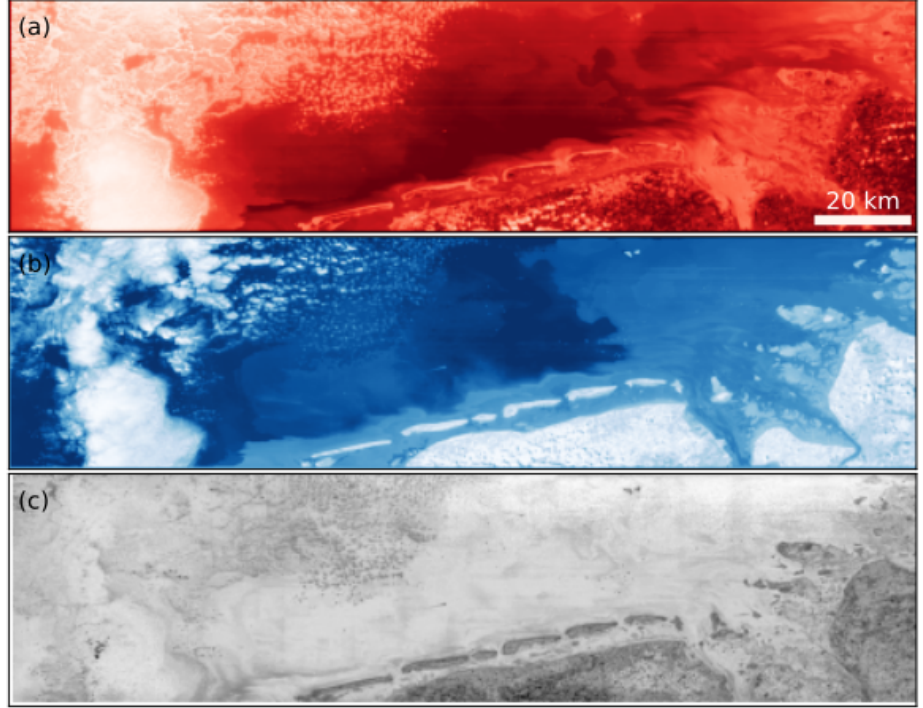
64 86 SOM. The ( a ) column and × ×